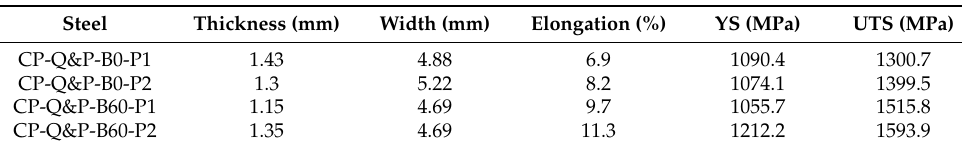
Table 2. Summary of the mechanical properties measured by means of uniaxial tensile tests of CP-B0 and CP-B60 steels produced in the Q&P treatment (P1 and P2).